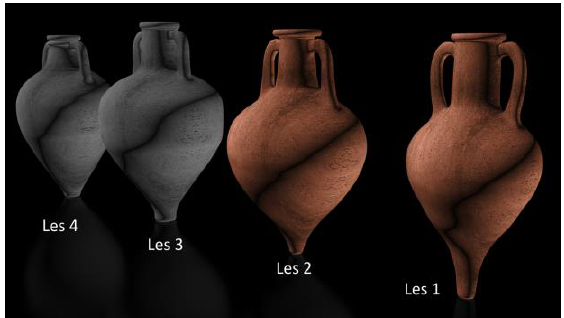
Figure 9 Two red and two grey Lesbian amphoras from the period 7 th -5 th century